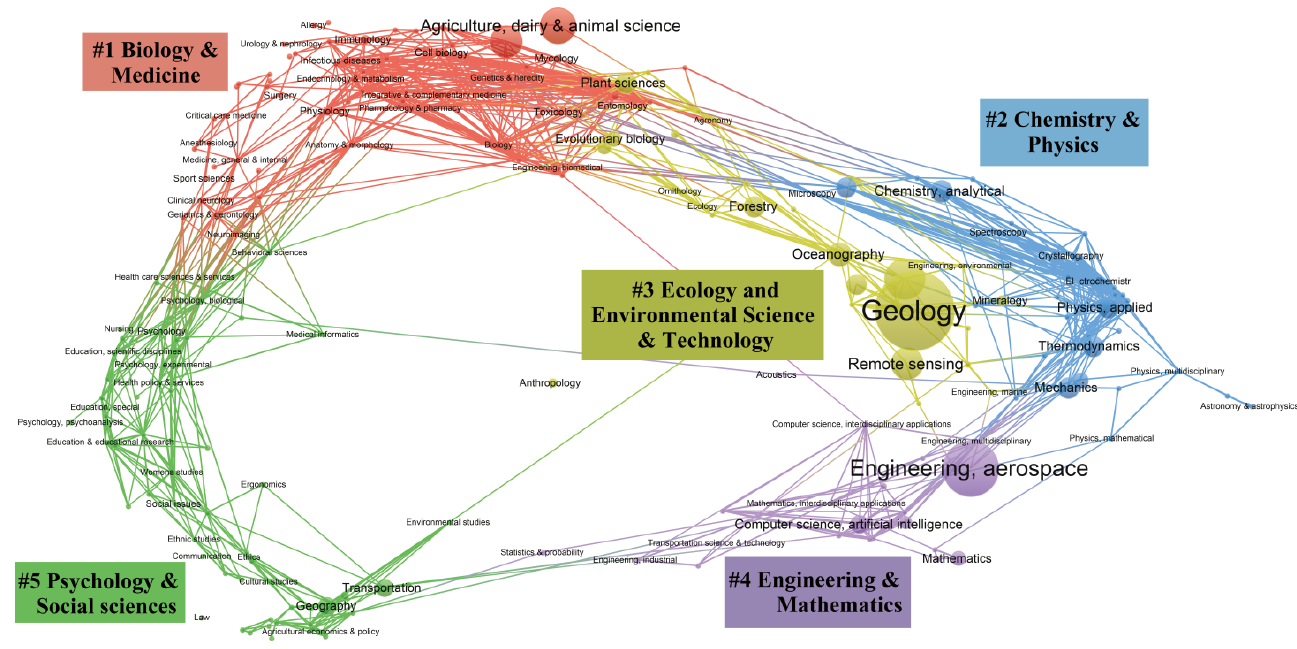
Figure 4. Superposition analysis of the distribution of the research fields of permafrost according to the aggregated journal citation data in 2015. Different colors represent different research categories, five in total, including Biology and Medicine, Chemistry and Physics, Ecology and Environmental Science and Technology, Engineering and Mathematics, and Psychology and Social